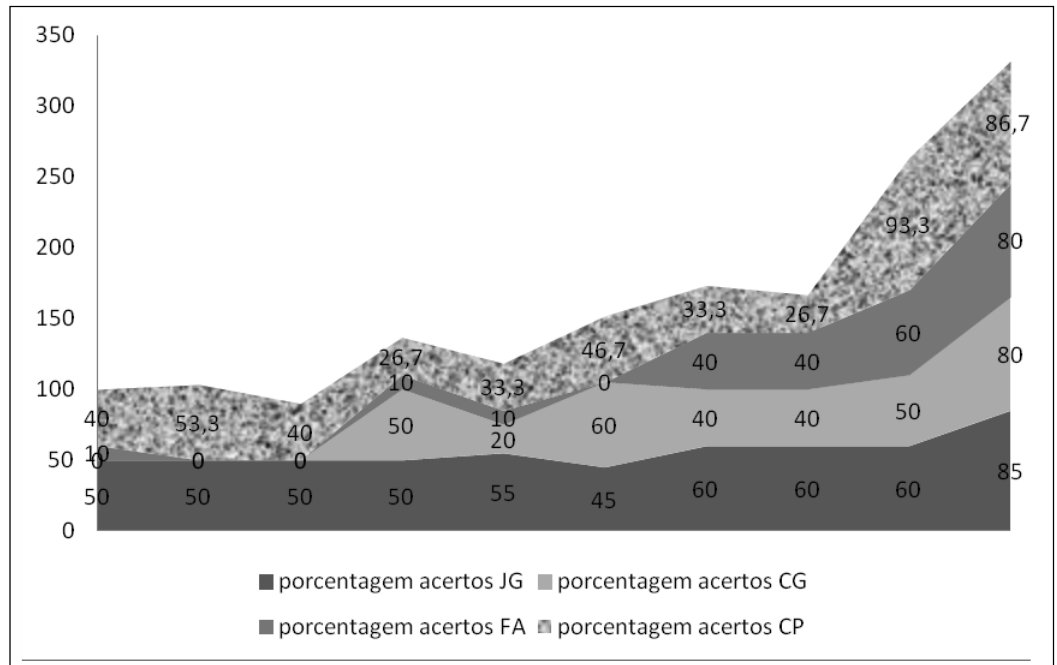
Figura 2 . Grá fi co com as porcentagens das pontuações brutas dos 10 sujeitos nos subtestes da PCF – Adaptada. Notas . Legenda: porcentagem acertos CP = porcentagem de acertos no subteste “categorização de palavras” da Prova de Consciência Sintática Adaptada; porcentagem de acertos FA = porcentagem de acertos no subteste “correção de frases agramaticais e assemânticas” da Prova de Consciência Sintática Adaptada; porcentagem de acertos CG = porcentagem de acertos no subteste “correção de frases agramaticais” da Prova de Consciência Sintática Adaptada; porcentagem de acertos JG = porcentagem de acertos no subteste “julgamento gramatical” da Prova de Consciência Sintática